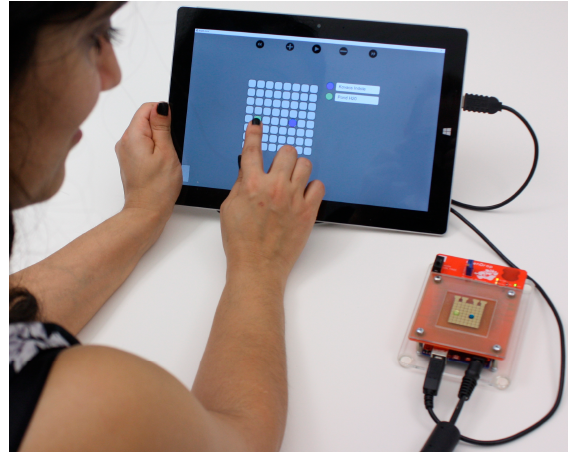
Figure 3. Our proposed system consists of an O PEN D ROP machine, a personal computer (tablet, smart phone) and the fluids needed for the target bio-application. The droplets are controlled real-time through the software interface by using touch-based gestures, such as drag and drop.